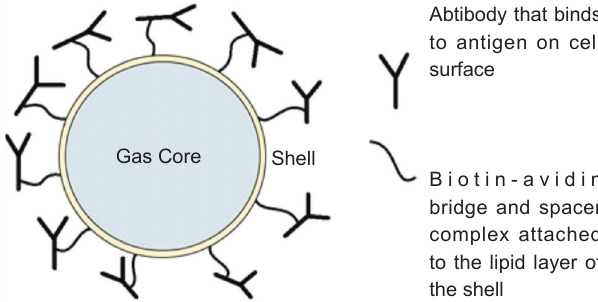
Figure 1 Illustration of a targeted microbubble complex composed of microbubble with gas core linked to antibody by a biotin-avidin and spacer complex.